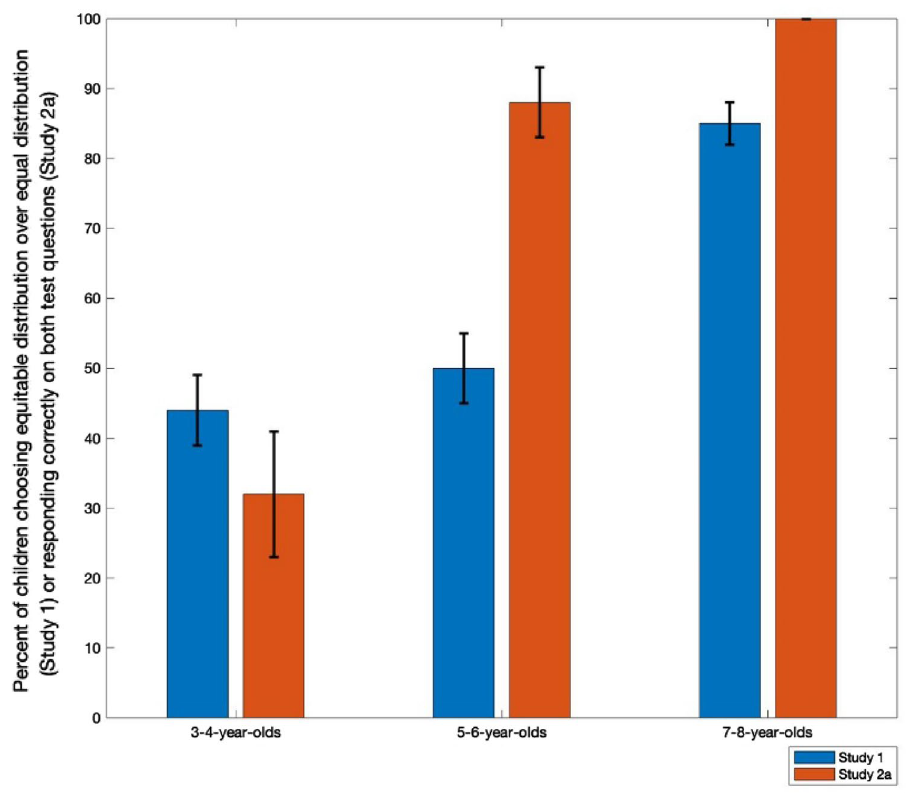
Figure 2. Percentage of children who chose the equitable distribution in Study 1 and responded correctly to the two number questions in Study